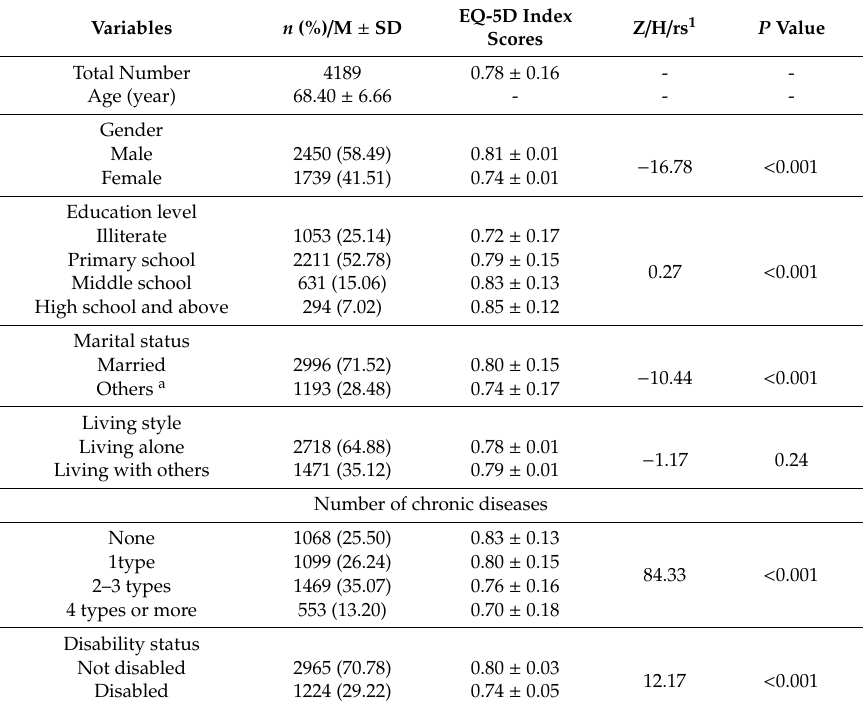
Table 1. The relationship between EQ-5D index scores and sociodemographic characteristic